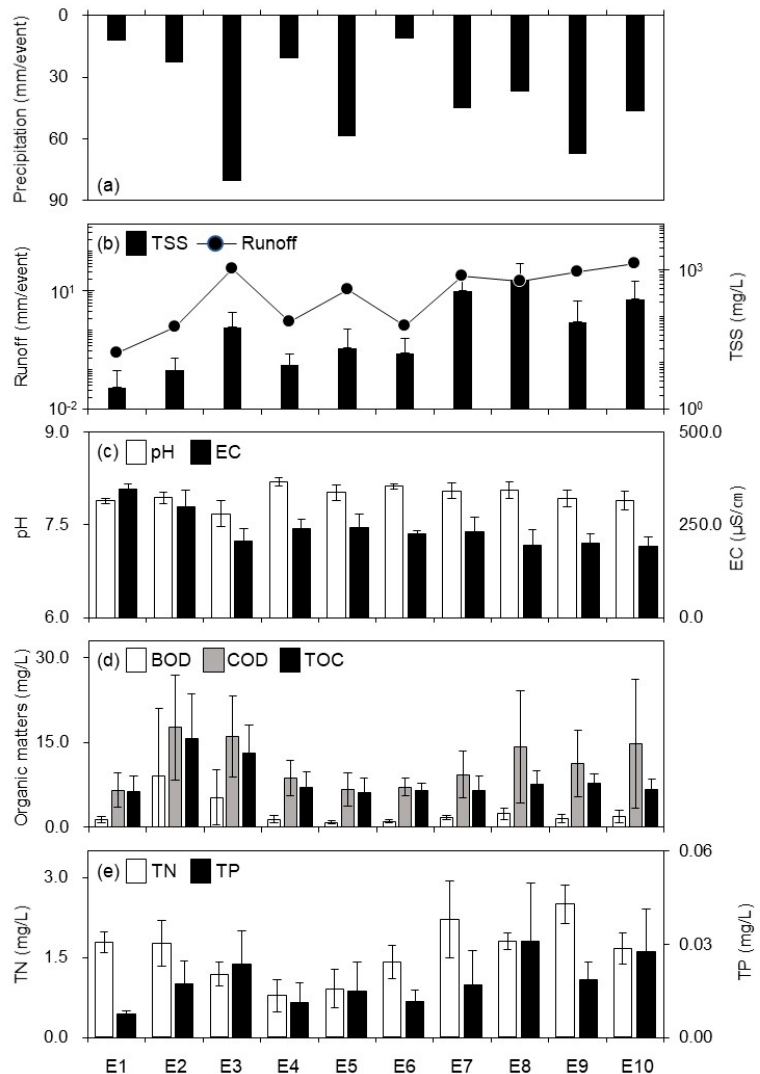
Figure 2. ( a ) Precipitation, ( b ) runoff and TSS, ( c ) pH and EC, ( d ) organic matter (BOD, COD, and TOC), and ( e ) TN and TP in a forested headwater stream during rainfall events (E1 − E10) in the immediate post ‐ fire period. TSS: total suspended solids, EC: electrical conductivity, BOD: biological oxygen demand, COD: chemical oxygen demand, TOC: total organic carbon, TN: total nitrogen, TP: total phosphorus.